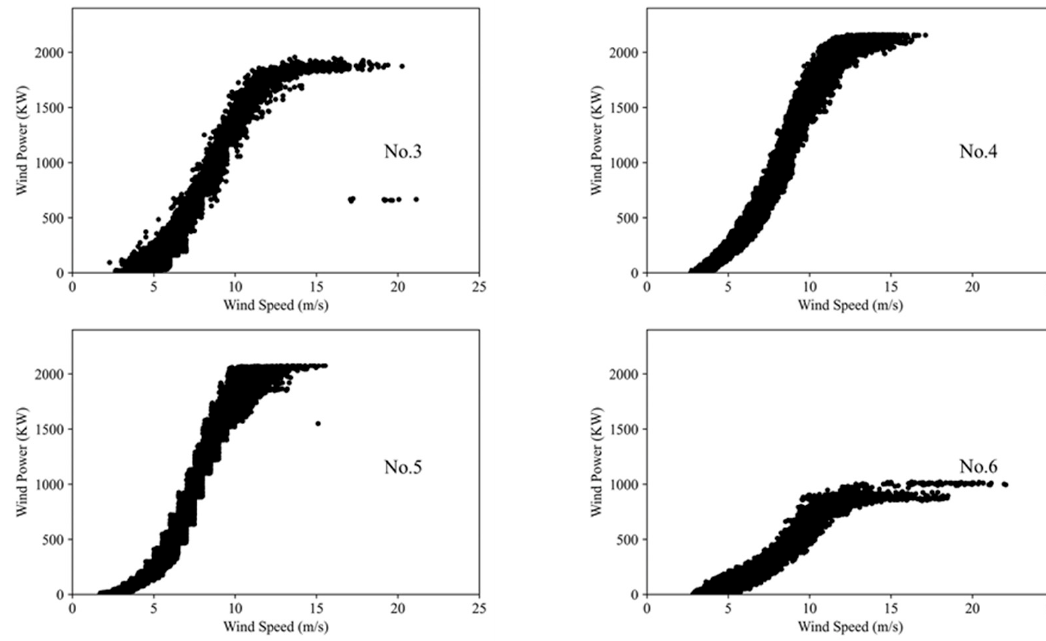
Figure 4. Abnormal data filtering result via QK.